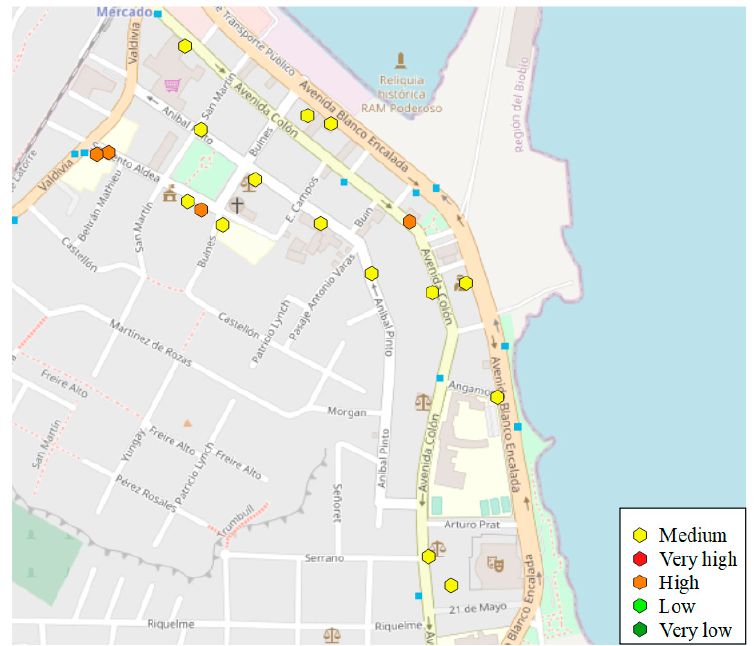
Figure 6. Vulnerability assessment